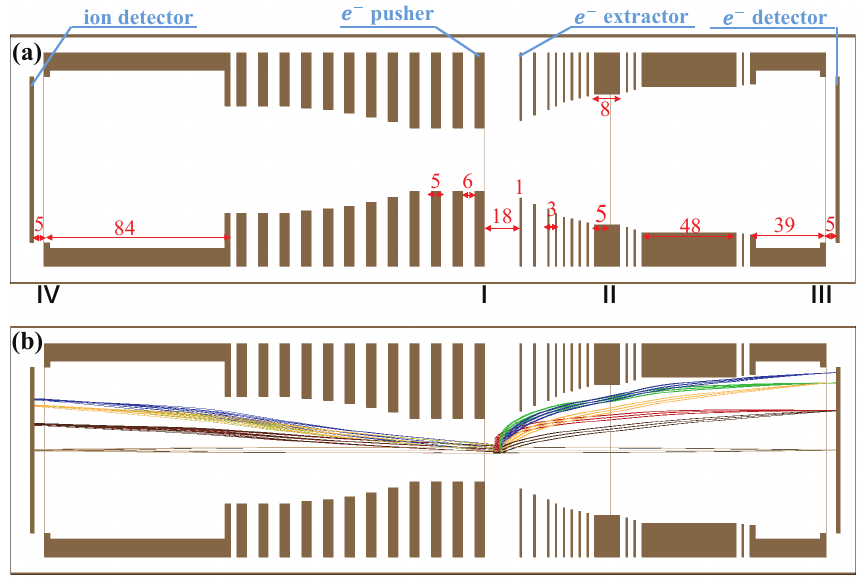
Figure 2. ( a ) The geometry of the electrostatic lens (length unit: mm). The electron arm and ion arm sit at the right and left sides, respectively. ( b ) SIMION simulated trajectories of the electrons with the kinetic energy of 1000 eV in the strong focusing mode and ions with the kinetic energy of 20 eV. The emission angles are 0 ◦ , 30 ◦ , 60 ◦ , 90 ◦ , 120 ◦ , 150 ◦ , and 180 ◦ with respect to the lens axis. The source region is defined as 9 particles emitted from a 1 × 3 mm 2